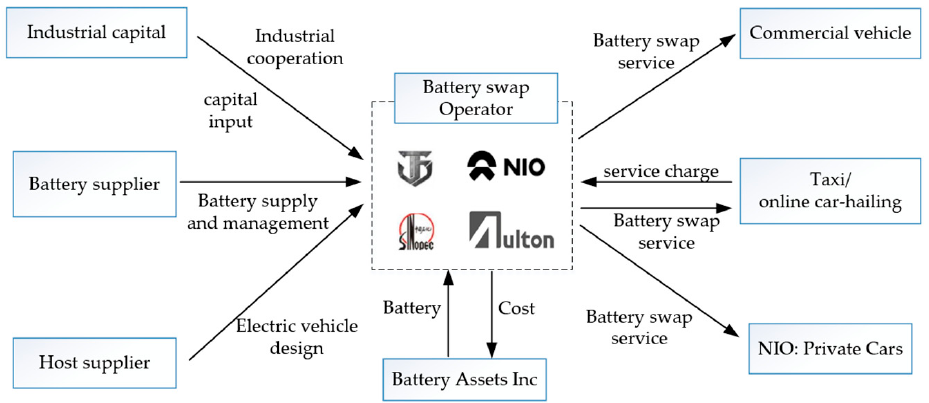
Figure 7. Battery swapping business model of Chinese enterprises.